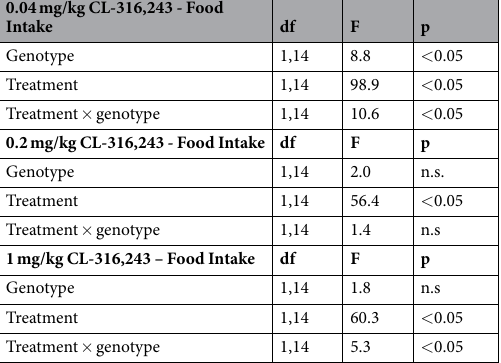
Table 9. Effects of CL-316,243 on food intake in WT and UCP-1 KO mice – statistical results.